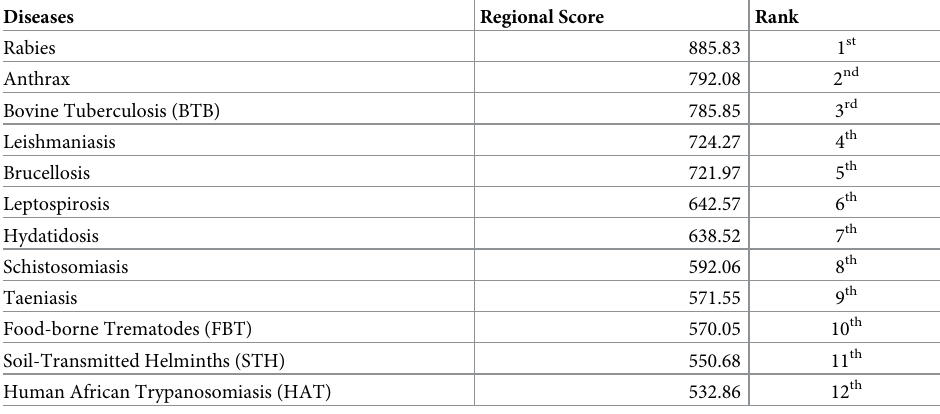
Table 5. Regional prioritization of neglected tropical zoonotic disease by experts.